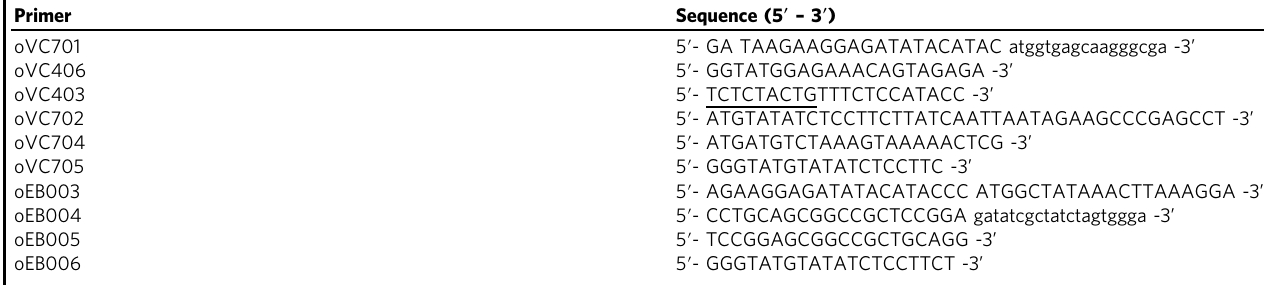
Table 1 Table of oligonucleotides used in this study.